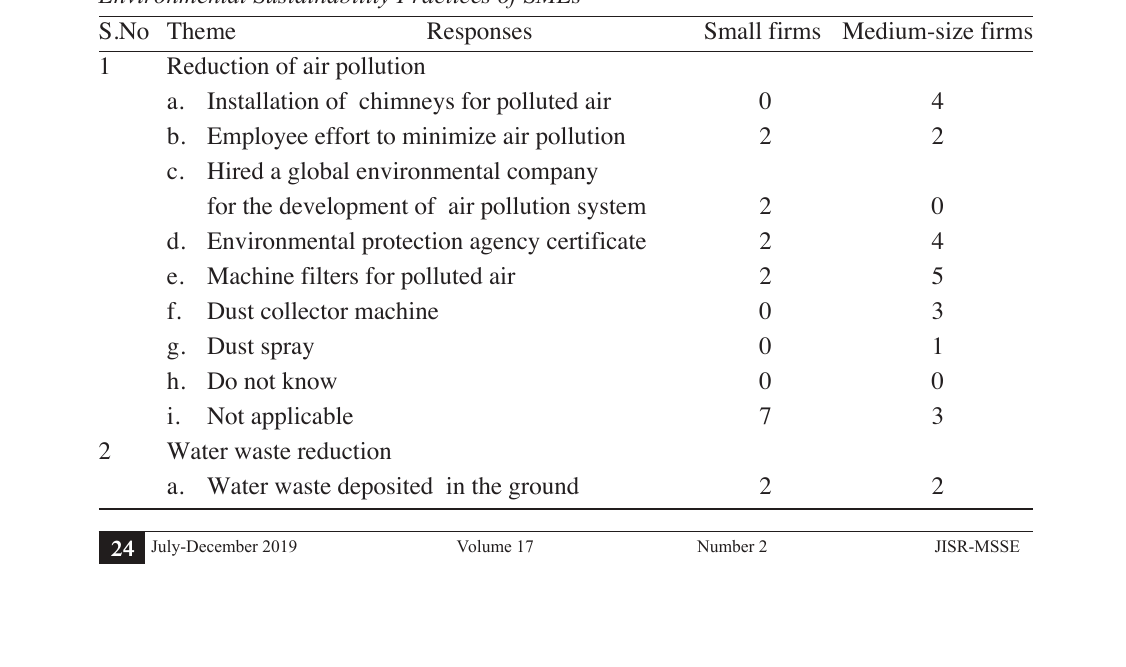
Environmental Sustainability Practices of